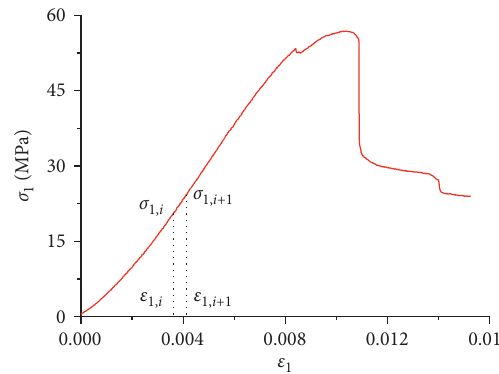
e and postpeak linear